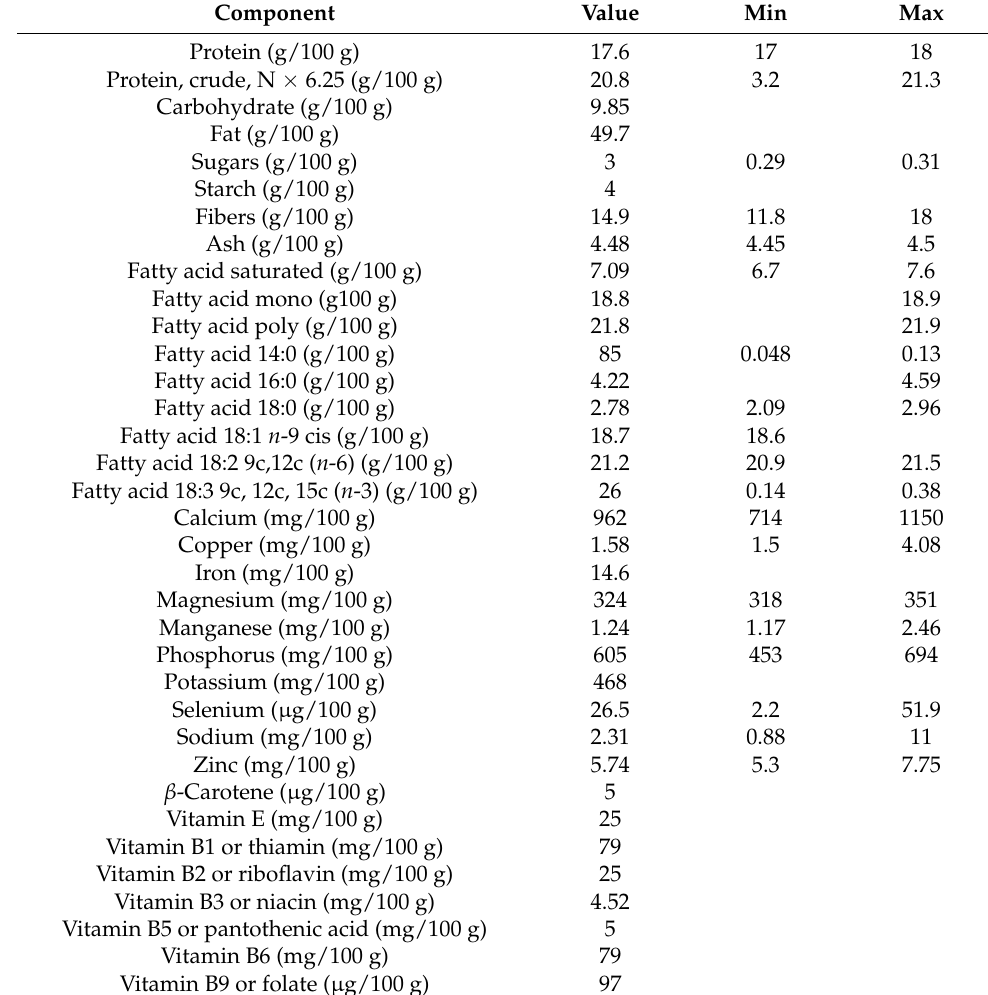
Table 1. Main nutritional constituents of sesame.